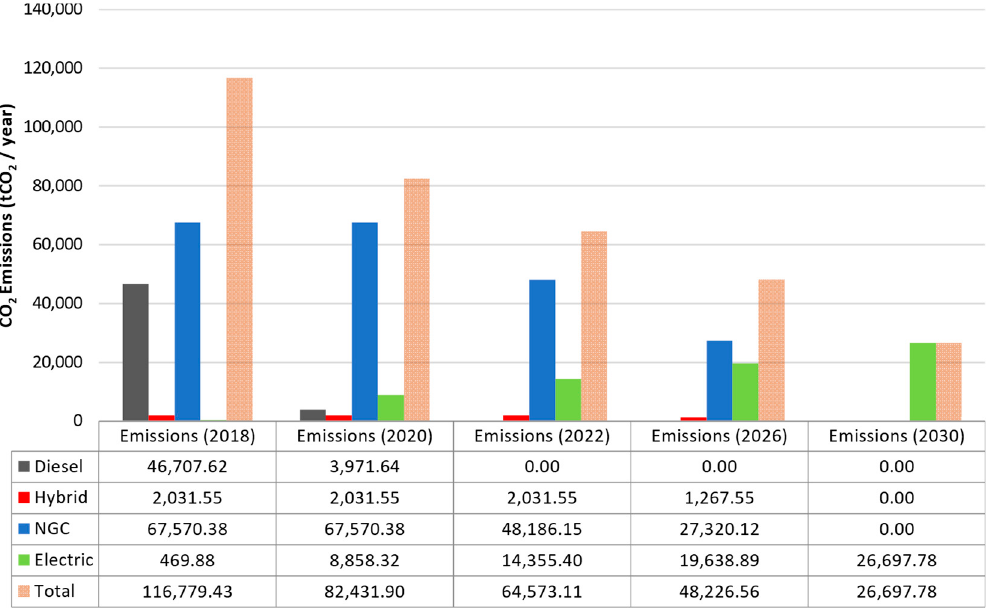
Figure 18. Comparison of the estimated CO 2 emissions for different bus fleet phases substitution with the current Spanish electricity mix.